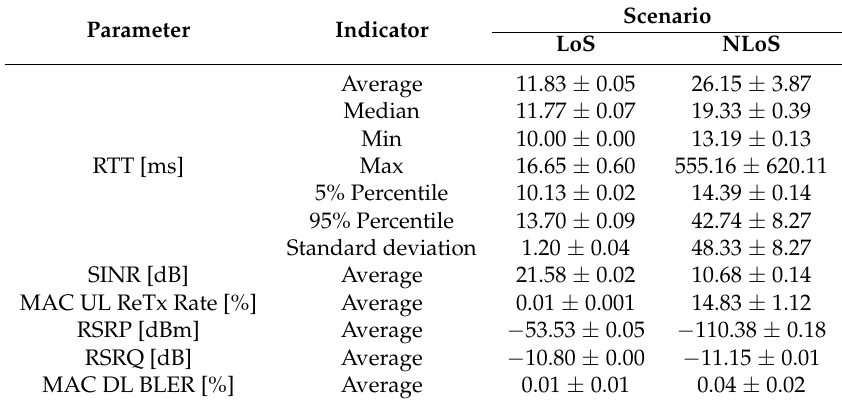
Table 5. Experiment 1: Statistical results for TC_RTT test case in SC_LoS_PS and SC_NLoS_PS scenarios (Acronyms as per Table 2; ReTx in MAC UL ReTx Rate stands for